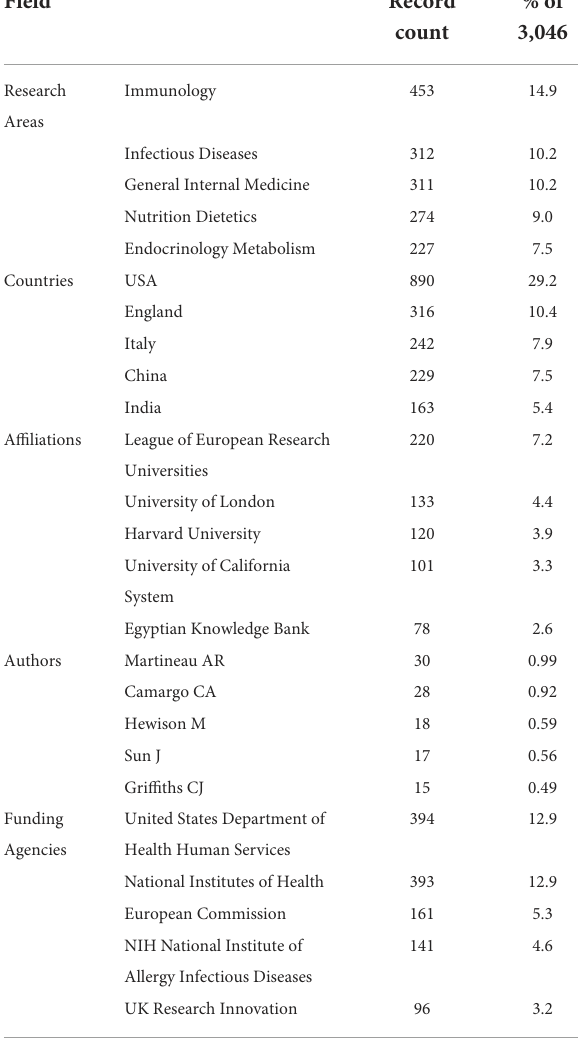
TABLE 1 Top five based on the number of documents